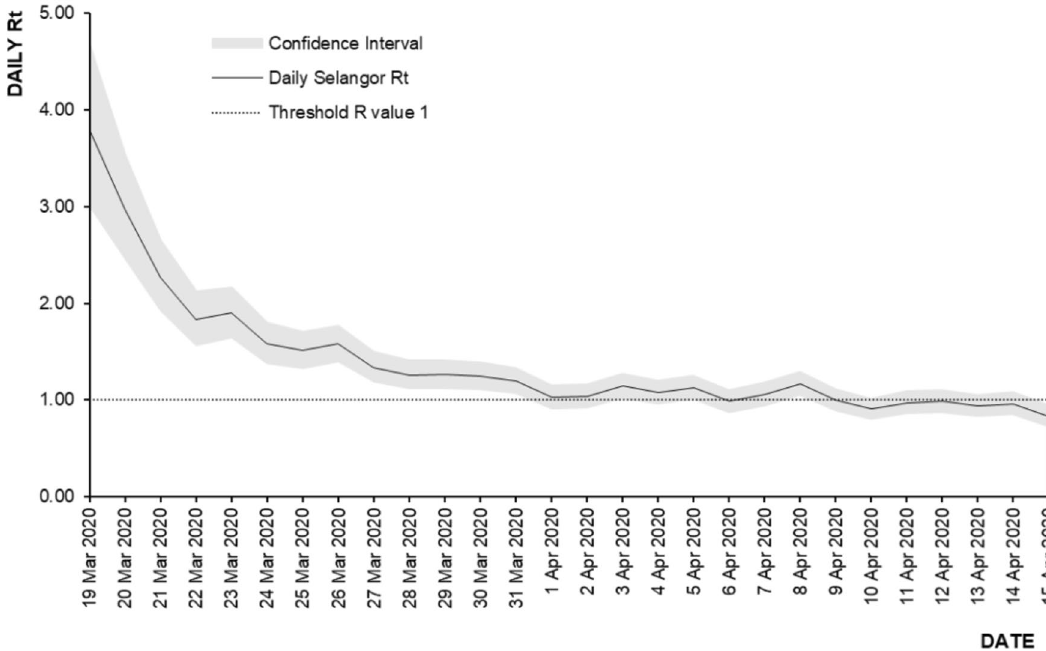
Figure 7. Rt trend following Sri Petaling mass gathering event, 19 March 2020 to 15 April 2020, Selangor. Sabah electoral process MCO MCO with CMCO Table 3. Estimated Rt values across various events for the third wave of COVID-19. Highest estimated Rt for the third wave of COVID-19 was 1.72 due to mass gathering in the Sabah electoral process.